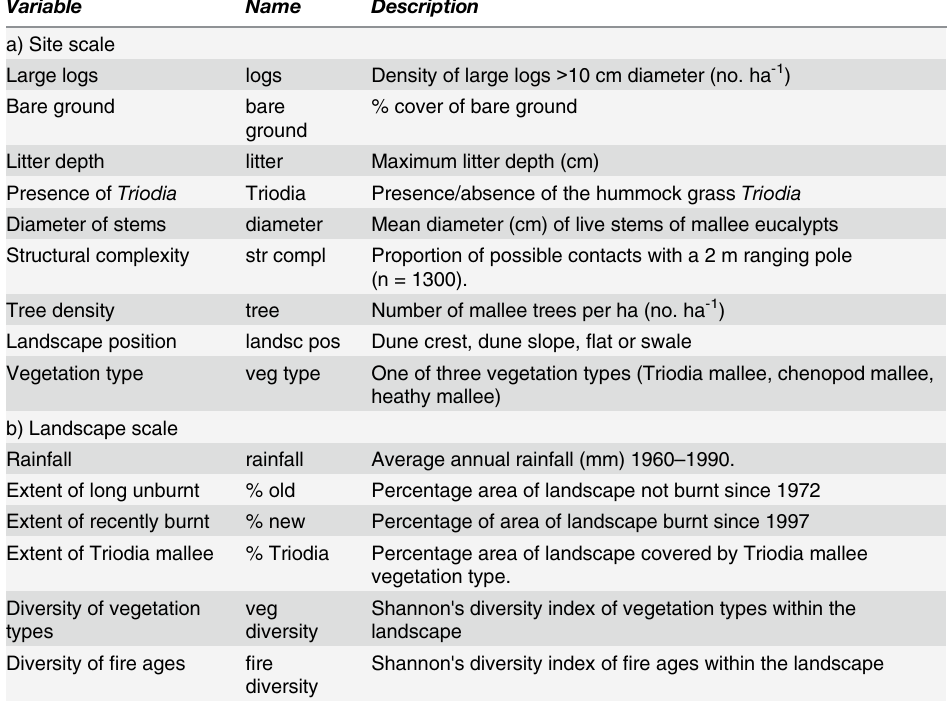
Table 1. Description of explanatory variables used to model the distribution of termite species and assemblages at a) site and b) landscape scales in the Murray Mallee